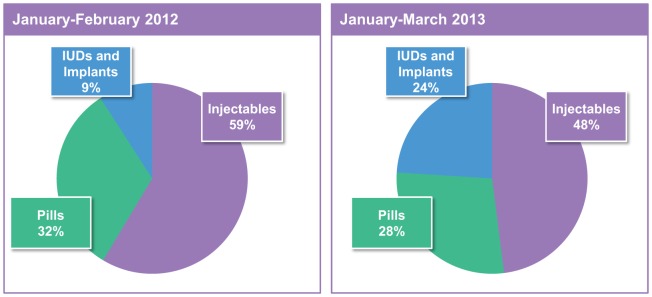
Method Mixa Before and 1 Year After IPM Implementation, Pikine District, Dakar, SenegalAbbreviations: IPM, informed push model; IUDs, intrauterine devices.a Excluding condoms.